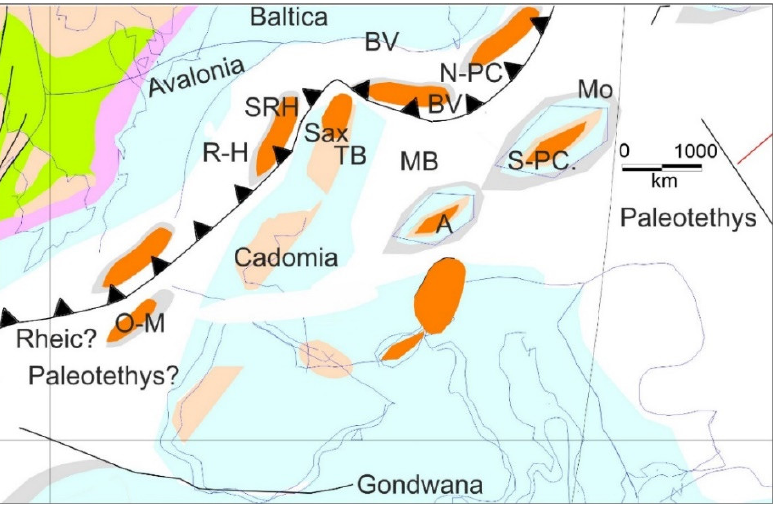
Figure 7. Paleogeography of the peri-Gondwanan domains on the Laurussia and European margins (central–southern Europe) during the Late Devonian (modified from [57]). Abbreviations: A—alpine